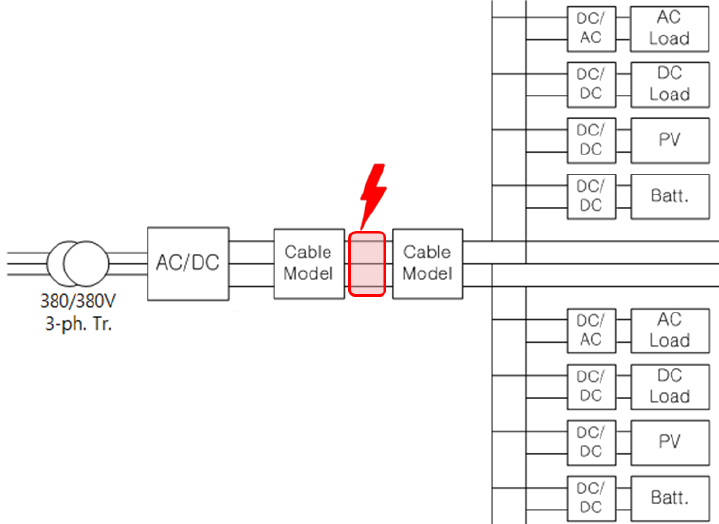
Figure 5. Overall schematic diagram of LVDC testbed model and fault